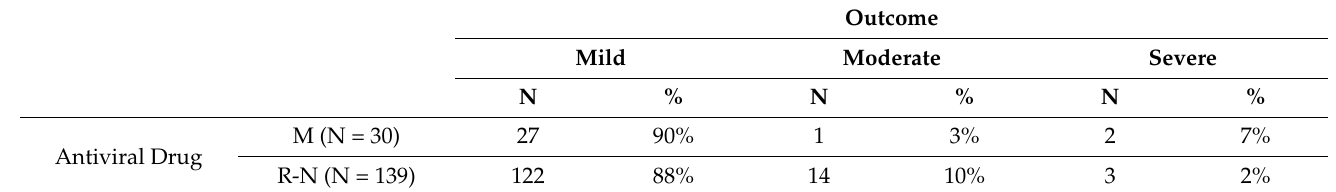
Table 4. Antiviral drug type and outcome of the SARS-CoV-2 infection (M: molnupiravir, R-N: